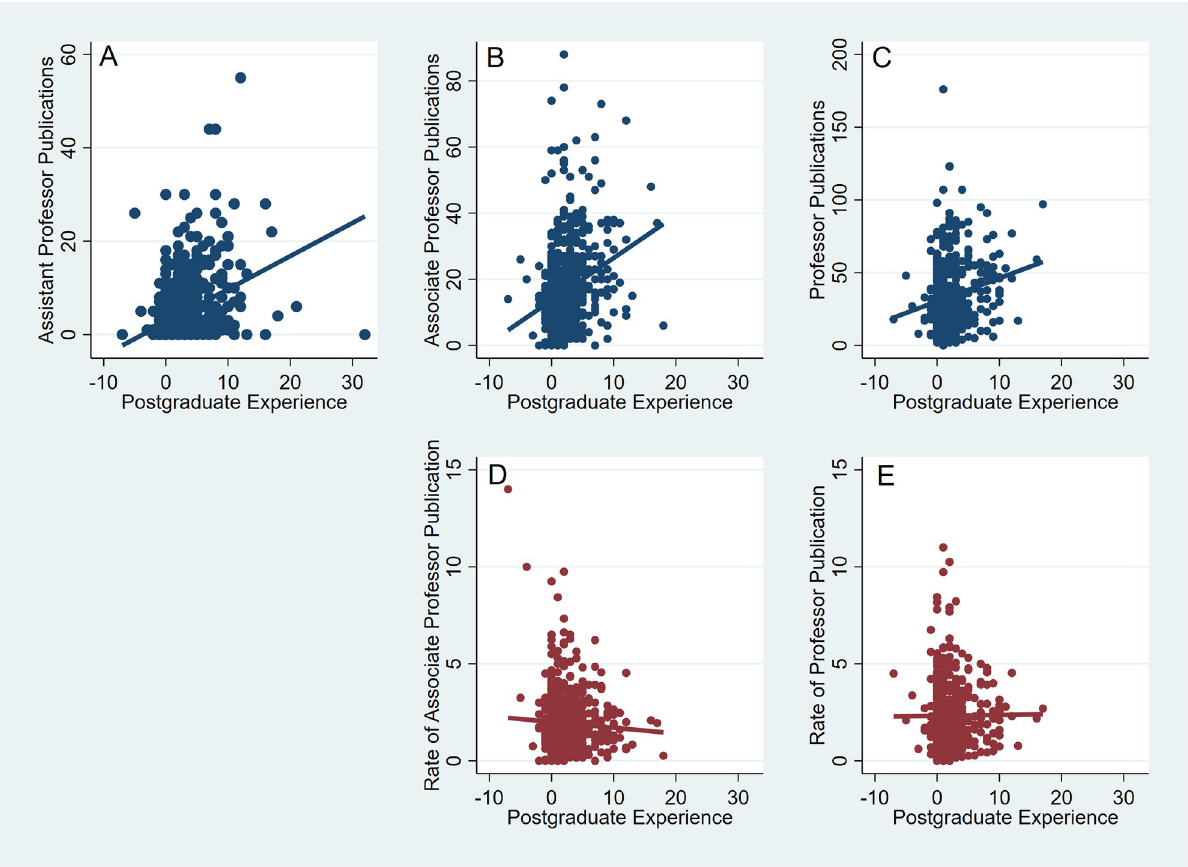
Fig 3. Postgraduate experience increases number, but not rate of publication. Plot of number of publications vs. years of postgraduate experience for assistant professors in A, associate professors in B, and full professors in C. Rate of publication plotted against postgraduate experience for associate professors is shown in D and for full professor in E. Lines are based on linear